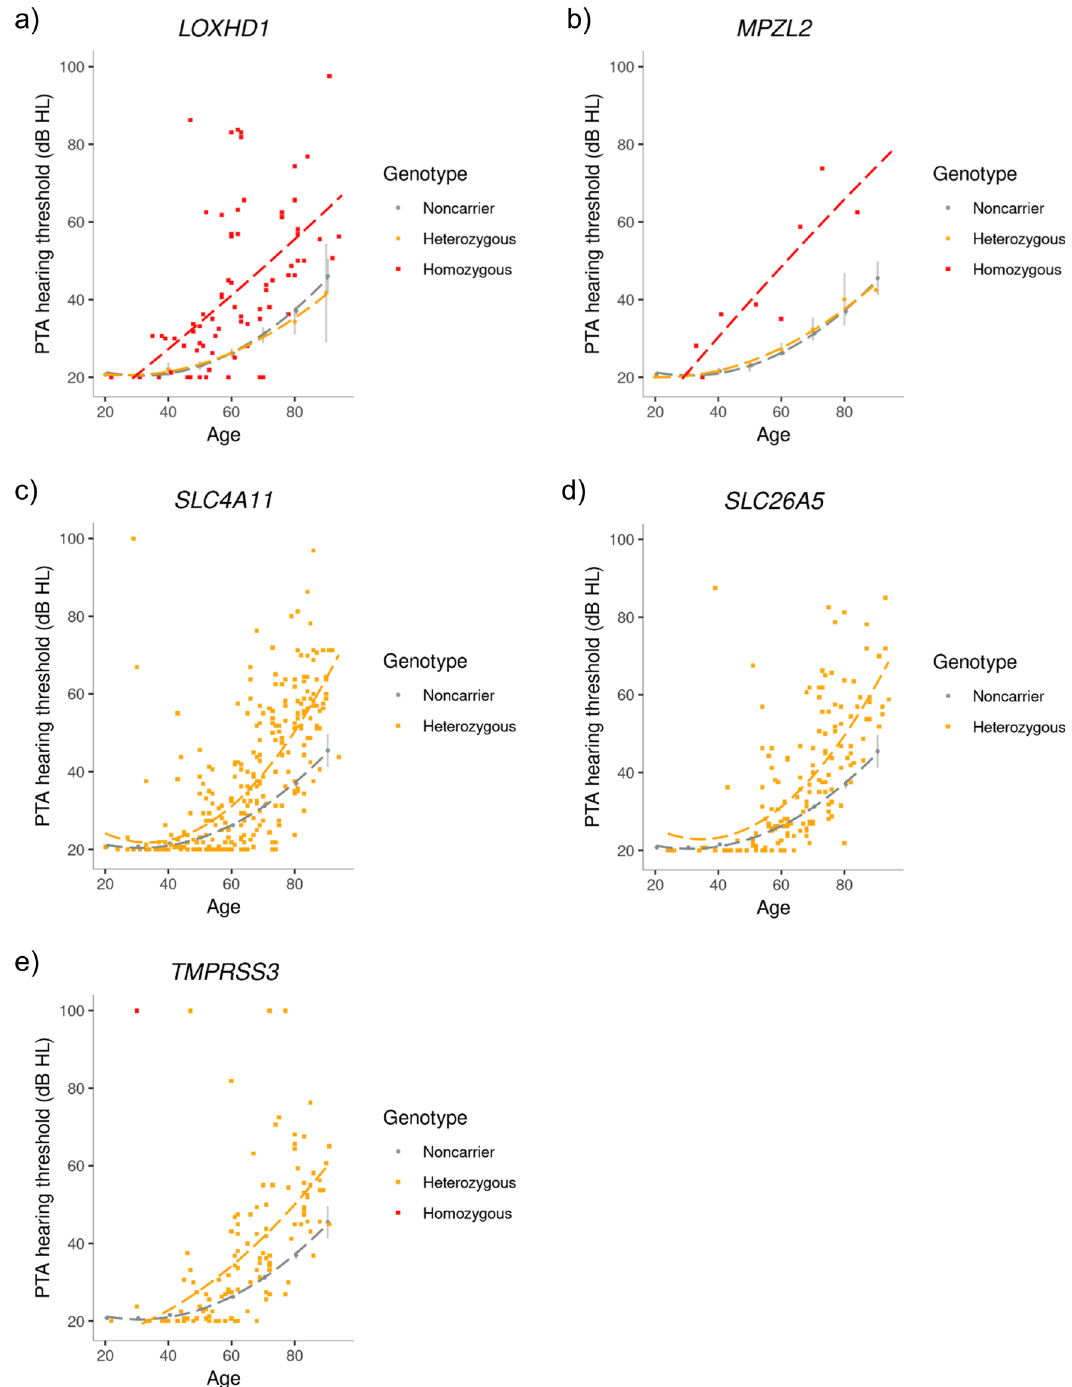
Fig. 4 Changes in PTA hearing thresholds by age for carriers of rare ARHI variants in Mendelian deafness genes. Effects of variants in a LOXHD1 , b MPZL2 , c SLC4A11 , d SLC26A5 , and e TMPRSS3 are shown. In a and b , the average PTA in the DHS dataset are represented with gray dots for non-carriers and orange dots for heterozygotes and the PTA hearing thresholds of the homozygous carriers in DHS and NIHSI datasets are represented with red squares. In c , d , and e , the average PTA of non-carriers in the DHS dataset are represented with gray dots and the PTA hearing threshold of the heterozygous carriers in DHS and NIHSI datasets by yellow squares. The dashed red lines are linear regression lines of best fi t and the dashed yellow and grey lines are polynomial regression lines of best fi t. The gray vertical lines represent 95% con fi dence intervals. A fi gure for TBC1D24 is not included because the variant was detected in UKB dataset only and therefore audiometric measures are not available for the